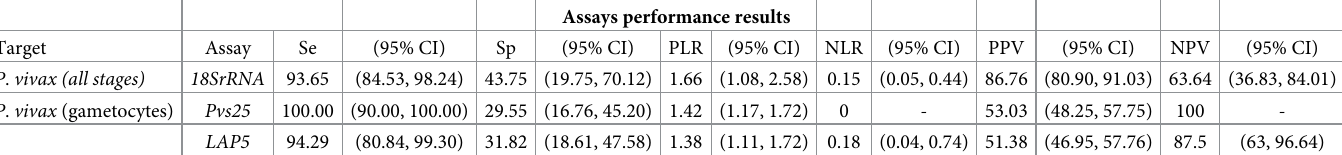
Table 4. Summary results of the field performance of a qRT-PCR assay for the detection of Plasmodium vivax gene transcripts in field samples preserved at ambi- ent temperature in RNAprotect compared to microscopy. Assays performance